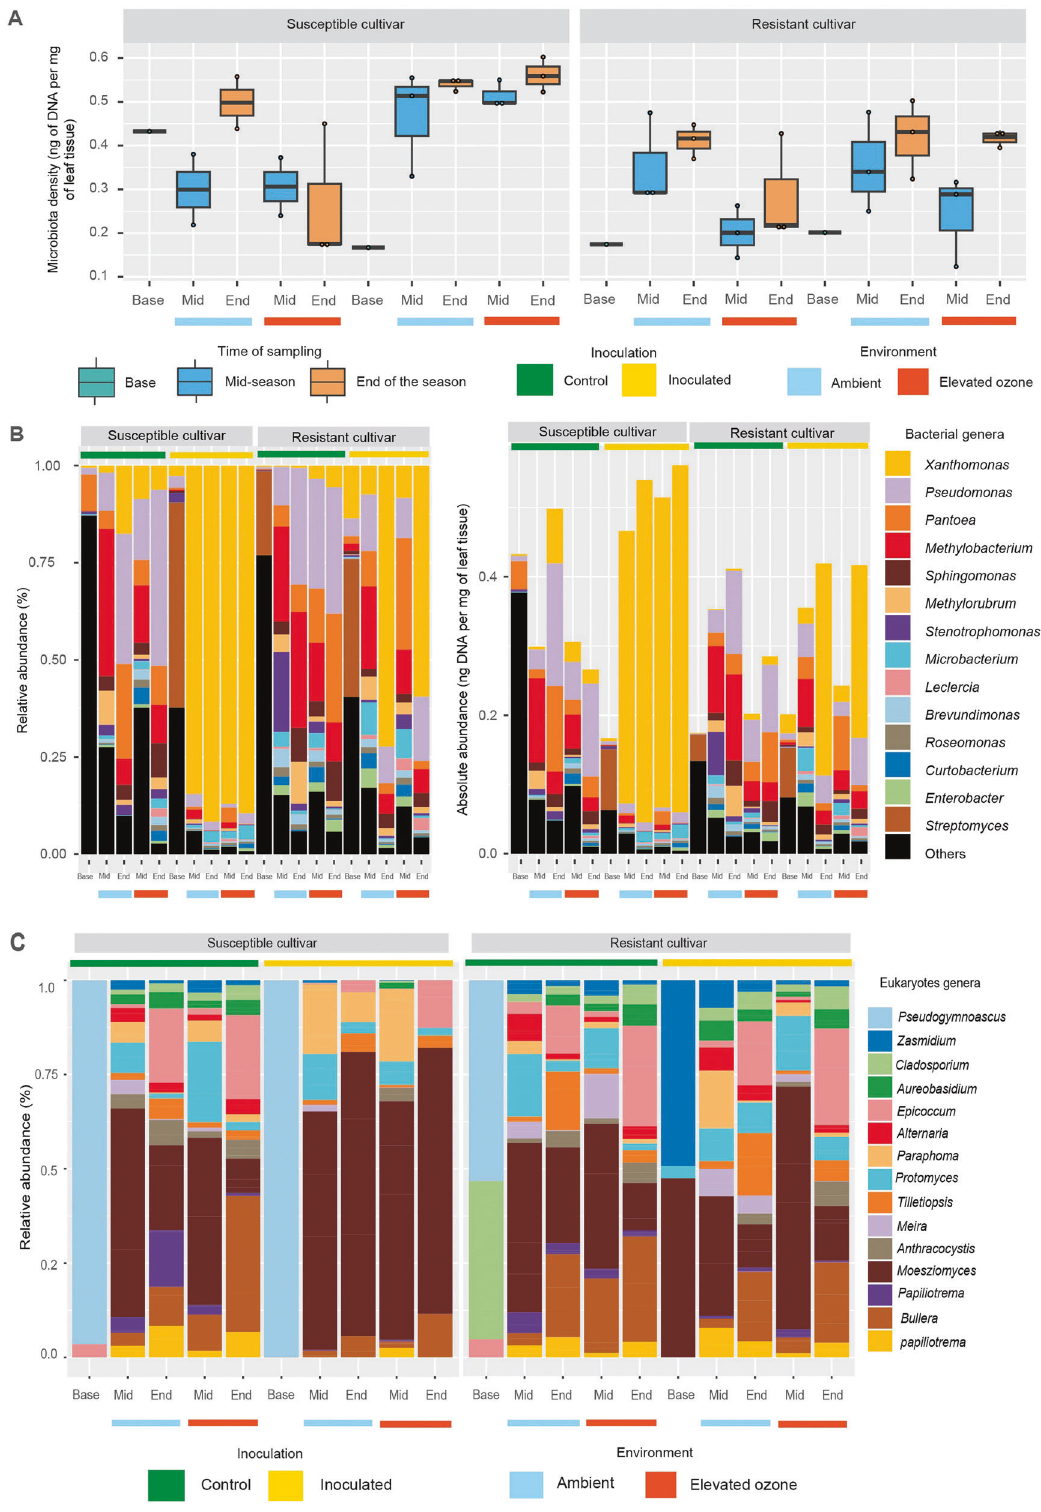
Fig. 4 The effects of elevated O 3 on disease outcomes are not fully explained by changes in microbiota density and abundance. A Box and whisker plot showing microbiota density estimated by microbial DNA quanti fi cation (concentration of extracted DNA per mg of leaf samples) for various treatment in two cultivars. B Relative (Left) and absolute (right) species abundance of top 15 bacterial taxa across samples. Absolute abundance is obtained by scaling the relative abundance measurements by the microbiota density measurements. C Bar plots showing the relative abundance of the top 15 eukaryotic genera across the samples. Inoculated and control samples are indicated with yellow and green bars on the top, while ambient and elevated O 3 treatments are denoted by light blue and red color bars at the bottom, respectively. The time of sampling is indicated by Base (initial samples), Mid (mid-season), and End (end of the